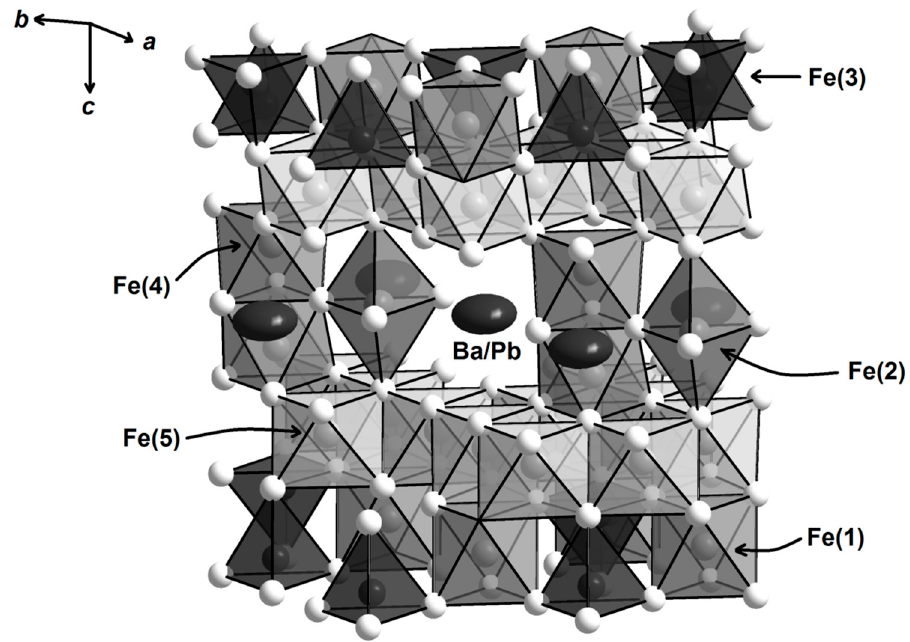
Figure 4. Section of the crystal structure of Ba 1–x Pb x Fe 12 O 19 .